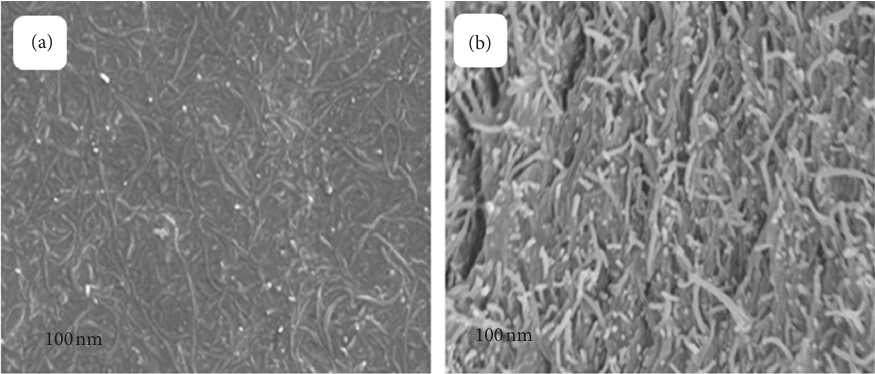
Figure 3: SEM of MWCNT/CHIT evaporative cast membrane. (a) Morphology of surface and (b) cross section.